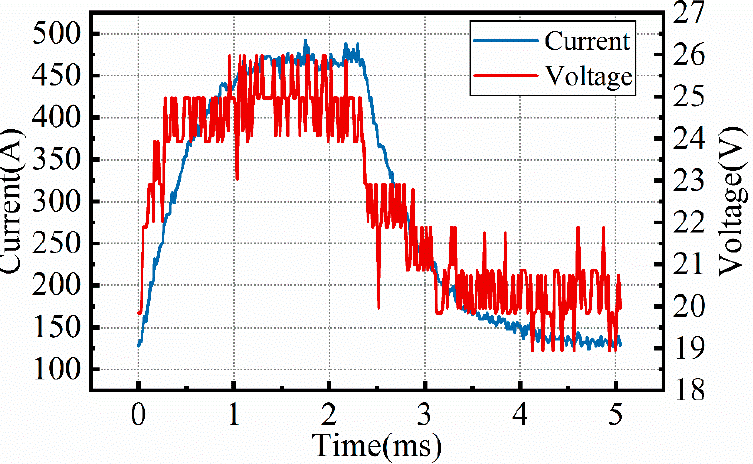
Figure 2. Time-dependent voltage and current